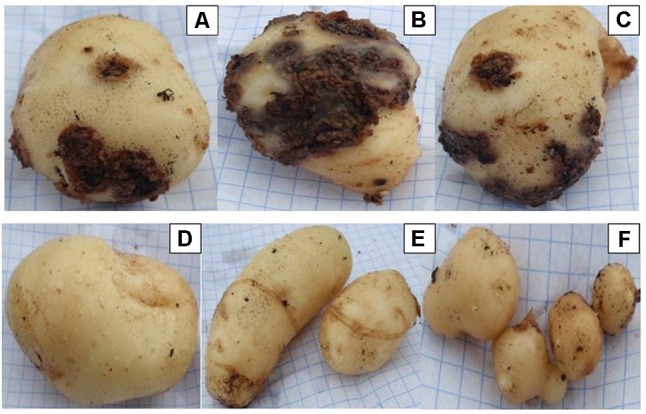
Potato tubers harvested from potting soil treated with Streptomyces strains (A) AC46; (B) AC56; (C) AC80; (D) A1RT+AC46; (E) A1RT+AC56; and (F) A1RT+AC80.